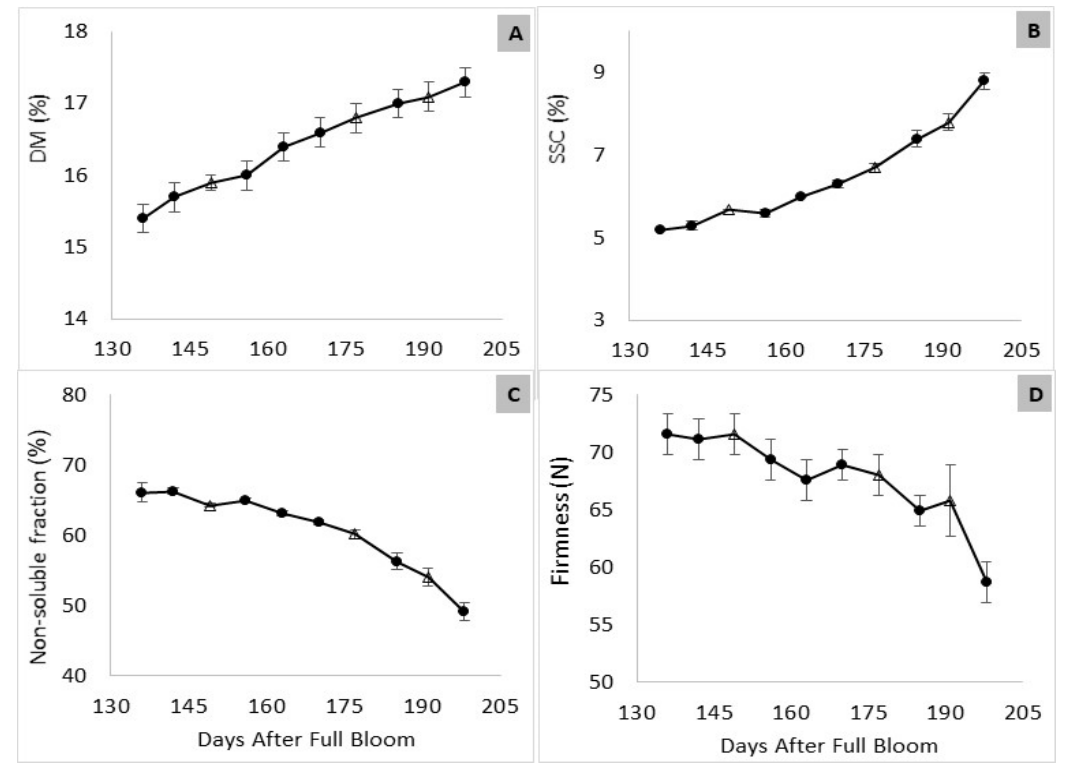
Figure 1. Progress of maturity indices during kiwifruit ripening: DM ( A ), SSC ( B ), NSDM ( C ), firmness ( D ), 2017. Harvests for fruit storage are marked by triangles.